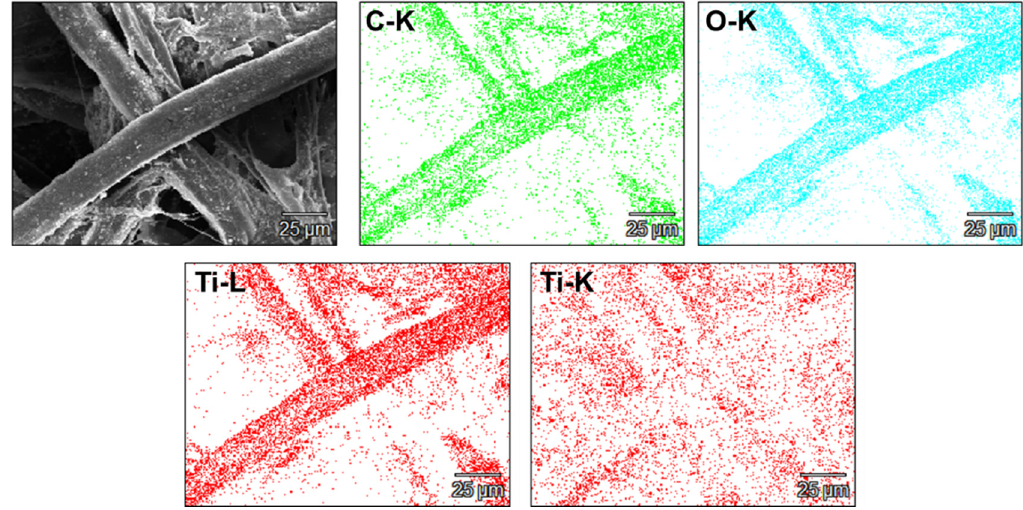
Figure 3. EDS mapping of cellulose fiber modified with TiO 2 8%.